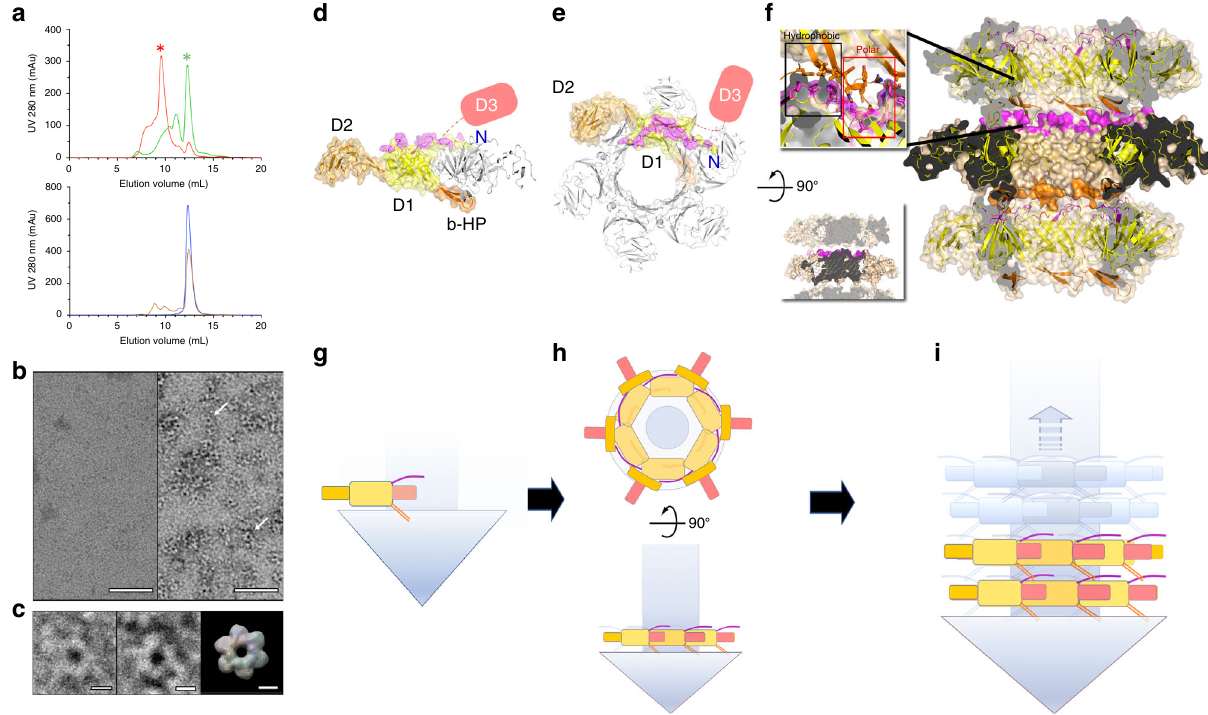
Fig. 8 Assembly of the YSD1 phage tail. a SEC chromatograms of YSD1_22 (green), a β -hairpin deletion mutant (delta- β HP, red), an N-terminal deletion mutant (delta-N, blue) and the double mutant (delta- β HP/delta-N, orange). Representative of three experiments from one (delta- β HP, double mutant) or two (YSD1_22, delta-N) puri fi cations. The UV absorbance at 280 nm is displayed in milli-absorbance units (mAU). The asterisks indicate the peaks selected for negative-stain EM. The mass of delta- β HP was estimated to 231.7 kDa ± 4.2% by multi-angle laser light scattering. Theoretical mass: monomer = 38.7 kDa, hexamer = 232.2 kDa. b Representative negative-stain EM images of YSD1_22 and delta- β HP at ×67,000 magni fi cation (two imaging sessions). c Zoomed view of ring-like objects highlighted by white arrows in b . For comparison, an hexameric ring of YSD1_22 is represented from the cryo-EM reconstruction of the assembled tail fi ltered to a resolution of 20 Å. Scale bars are 50 nm for b and 5 nm for c . d , e Orthogonal views of the hexameric rings forming the tail tube. For one subunit, domains 1, 2 and 3 and the β -hairpin ( β -HP) are shown in yellow, brown, cyan and orange, respectively. Residues involved in inter-ring contacts are shown in magenta. Other subunits are coloured in grey and only one of these is shown in the side view of the ring. f A cross-section of the tail tube is shown as a ribbon within a brown molecular surface. Bottom-left inset: same view omitting β -HP. Top- left inset: zoom of the inter-ring interactions. Black and red boxes indicate contact areas with predominantly hydrophobic and polar interactions, respectively. g – i Model of the tail assembly process: Upon nucleation by the initiator (tail tip, represented as a blue triangle, or tail chaperones complex including the tape measure protein, represented as a blue cylinder), the N-terminus and β -HP form a splayed conformation ( g ), which is compatible with a stable hexameric ring ( h ). This conformation also positions the N-terminal arm and β -HP on either side of the rings making them available for axial polymerisation of the helical tail ( i